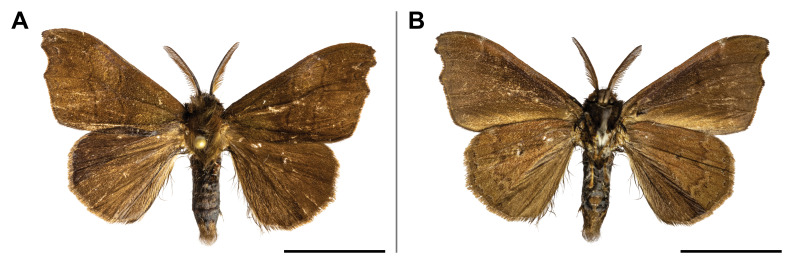
Lomadonta
saturata Swinhoe, 1904. A. dorsal view; B. ventral view. The scale bar represents 1 cm.